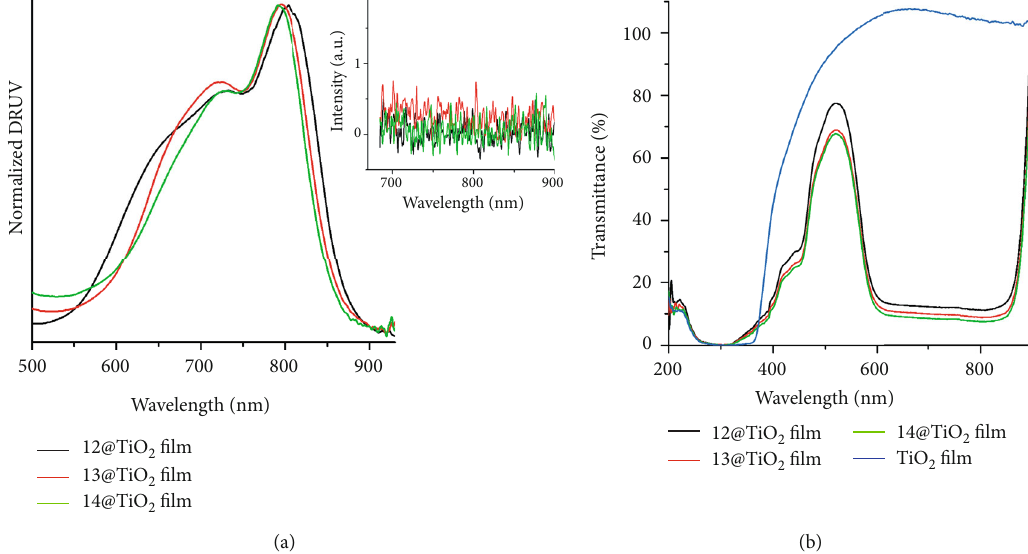
Figure 2: Normalized (a – c) Vis-NIR and (d – f) fl uorescence emission spectra in solution (10 -6 M) of the carboxy heptamethine dyes 12-14. Table 2: Photophysical data of compounds 12-14 in solution, where λ ( × 10 5 ) is the molar absorptivity coe ffi cient, Δλ